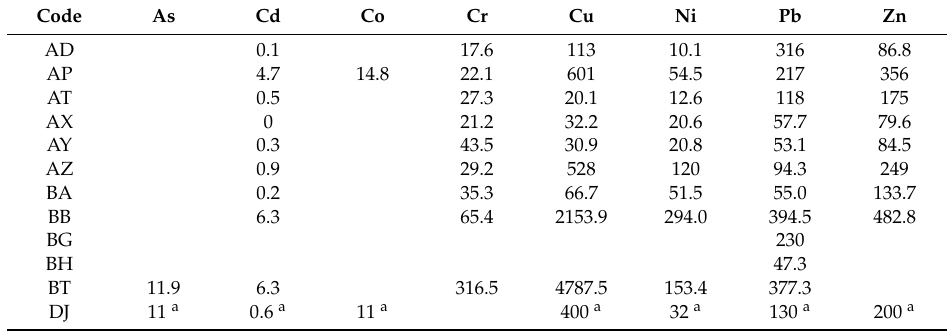
Table 4. Concentration of heavy metals and metalloids in sediments (values expressed in mg / kg). Code